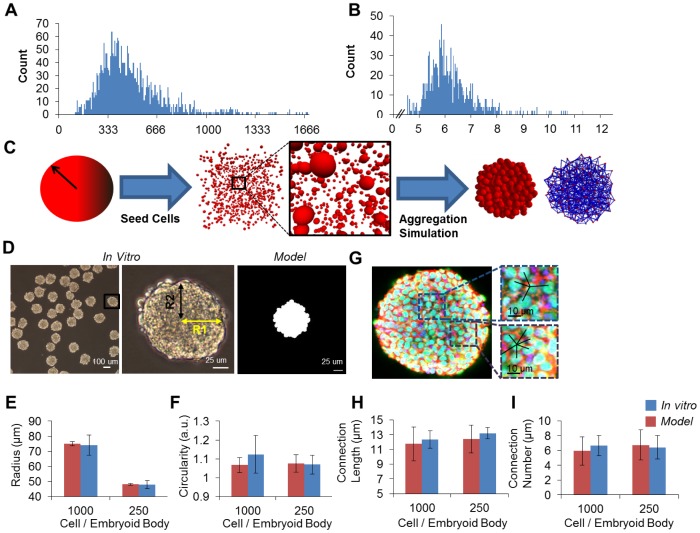
Aggregate modeling methodology.Dissociated mouse embryonic stem cells (mESCs) were analyzed via Coulter counter for surface area (A) and radius (B). In silico aggregates were generated in a physical modeling process in which cells were generated and then forcibly aggregated (C). Embryoid bodies (EBs) were formed via ultra-high throughput methods for two initial cell numbers: 250 and 1000 - a representative image for 1000 cell EB is shown (D). The black box in first column is digitally enlarged in the second column. Circularity was calculated by fitting the EB to an ellipse and taking the ratio of the two radii labeled R1 and R2 respectively. EBs were analyzed for two macro scale aggregate properties: radius (E) and circularity (F). Confocal images were used to analyze local aggregate properties –a representative 1000 cell EB image is shown (G). Aggregate local properties were assessed by two metrics: connection length (H) and number of connections (I).